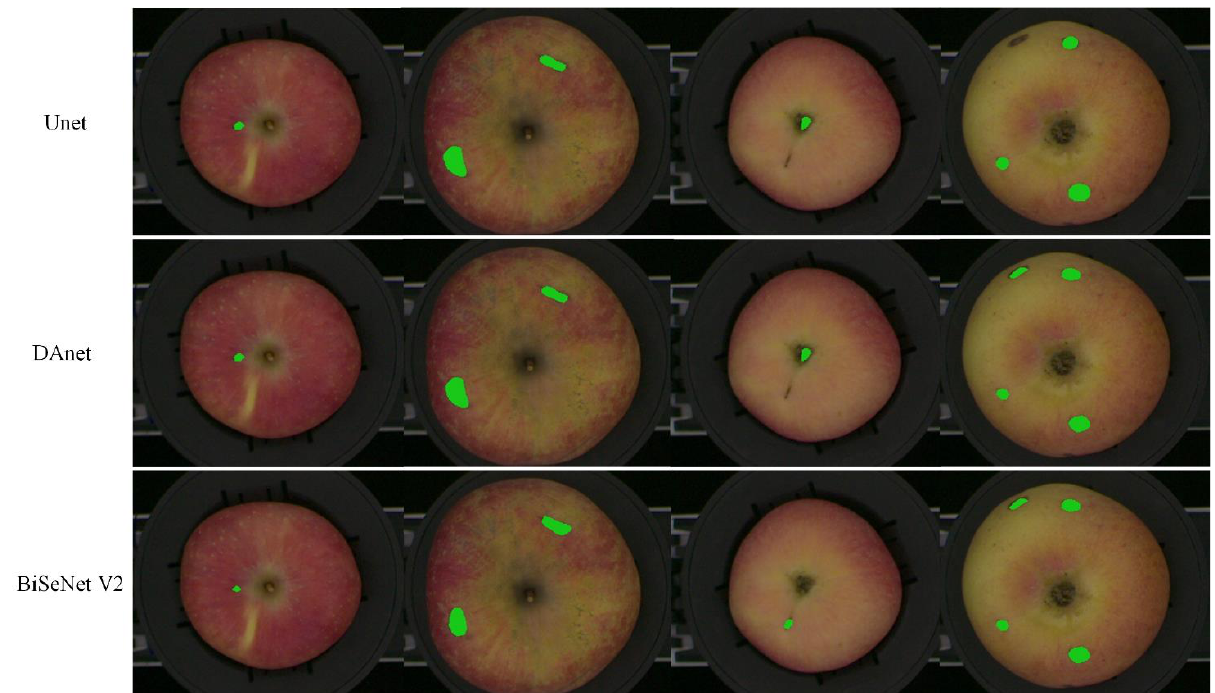
Figure 6. The segmentation results of the Unet, DAnet and BiSeNet V2 networks. Table 2. The comparison of different semantic segmentation